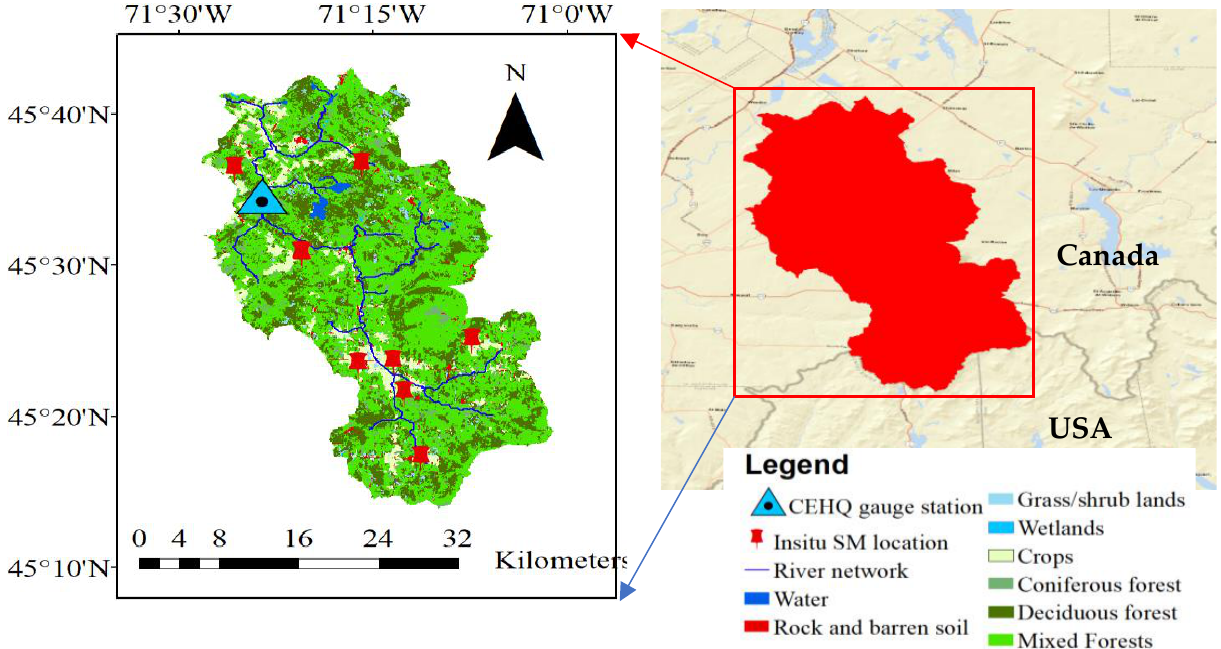
Figure 1. Location of the study area and location of in-situ soil moisture probes.